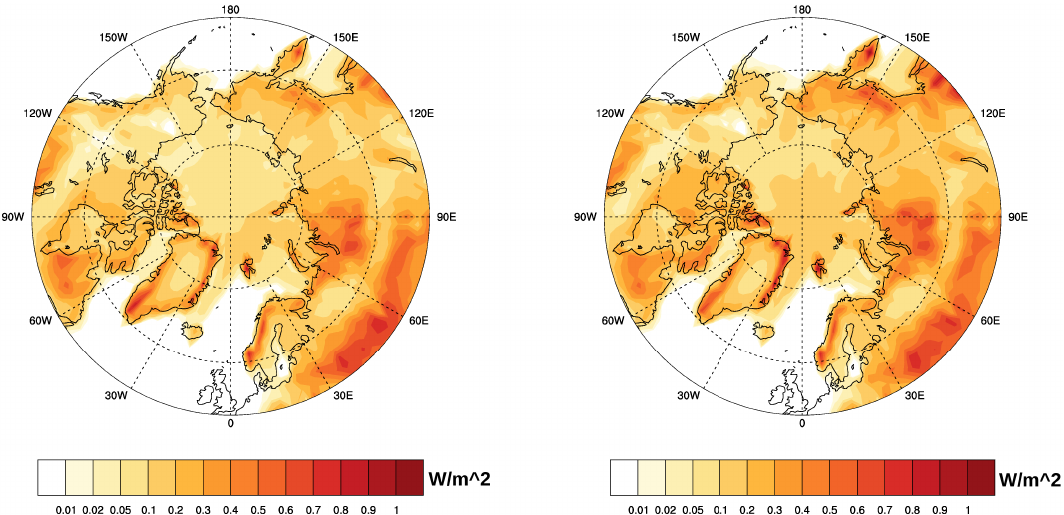
Fig. 13. Annual mean BC-in-snow radiative effects averaged across Phase I (left) and Phase II (right) models with inefficient meltwater scavenging.